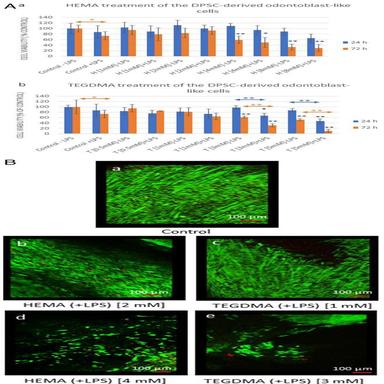
A: Cytotoxic effects of LPS and/or resinous monomers HEMA (a) or TEGDMA (b) on the DPSC-derived living (green) cells, that turned red, due to intercalation of the EthD-1 dye into their DNA, after cell membrane damage.